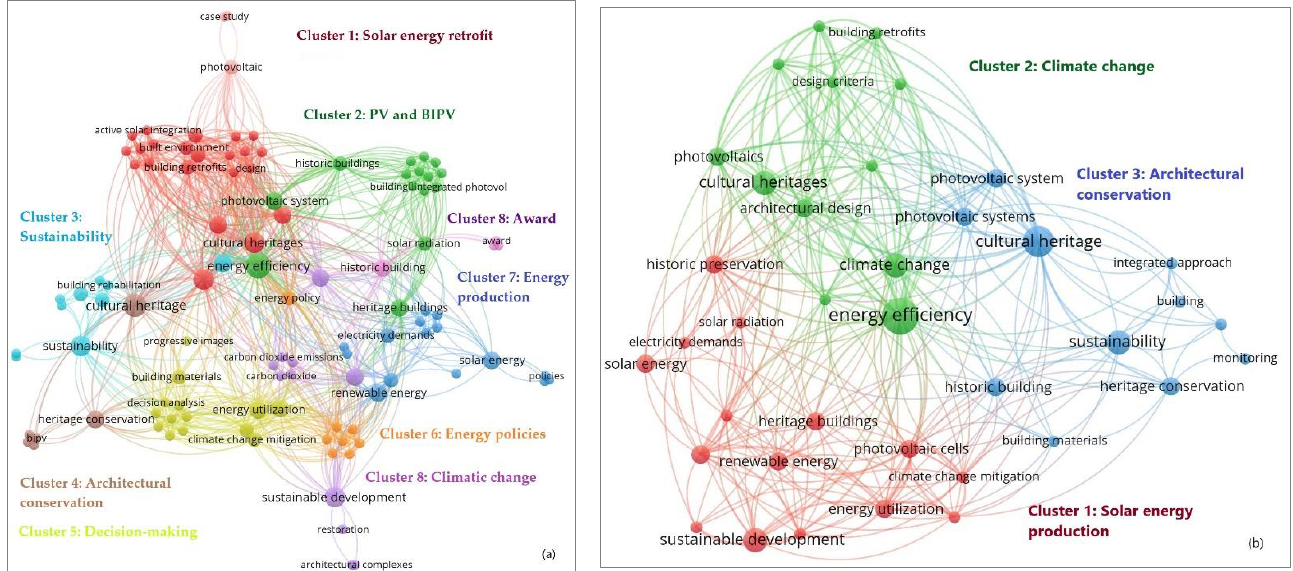
Figure 3. Scientific landscape of architectural heritage and solar energy and architectural heritage